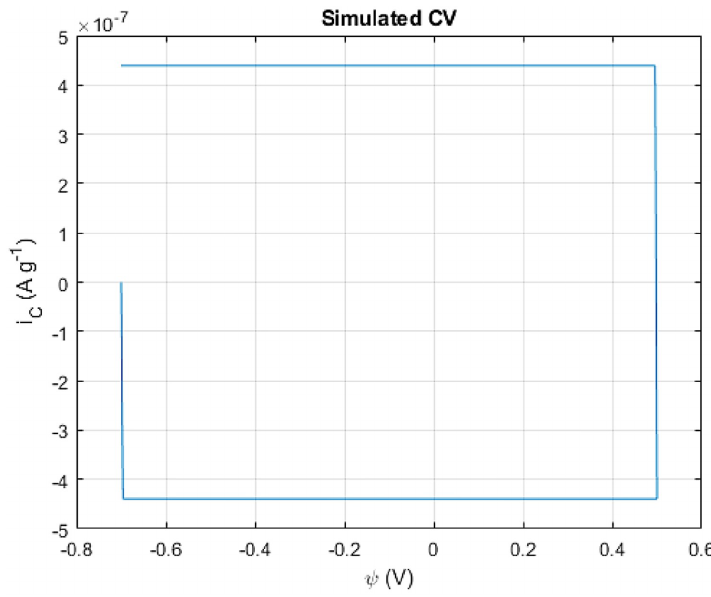
Figure 4. 1. Figure 7. Simulated capacitive contribution to CV